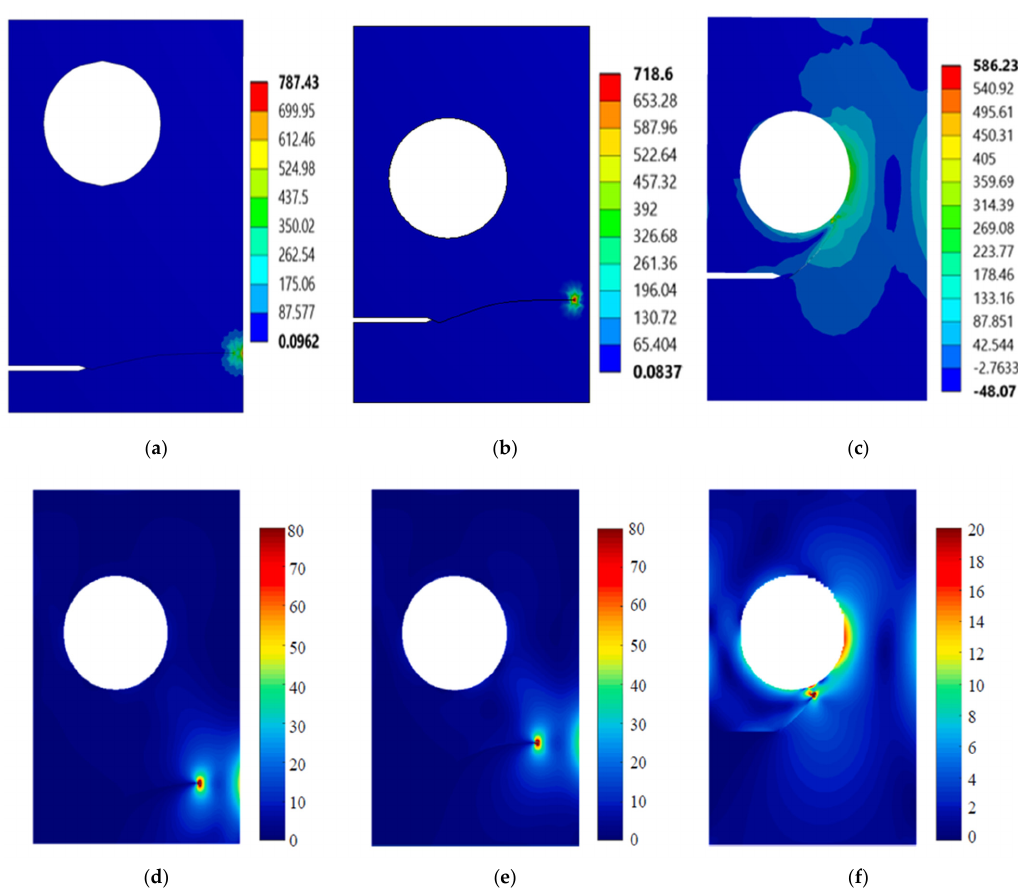
Figure 20. Comparison for the von Mises stress distribution (MPa) ( a ) h = 15 (present study), ( b ) h = 10 (present study), ( c ) h = 5 (present study), ( d ) h = 15 [52], ( e ) h = 10 [52], ( f ) h = 5. Copyright permission obtained from Elsevier [52].